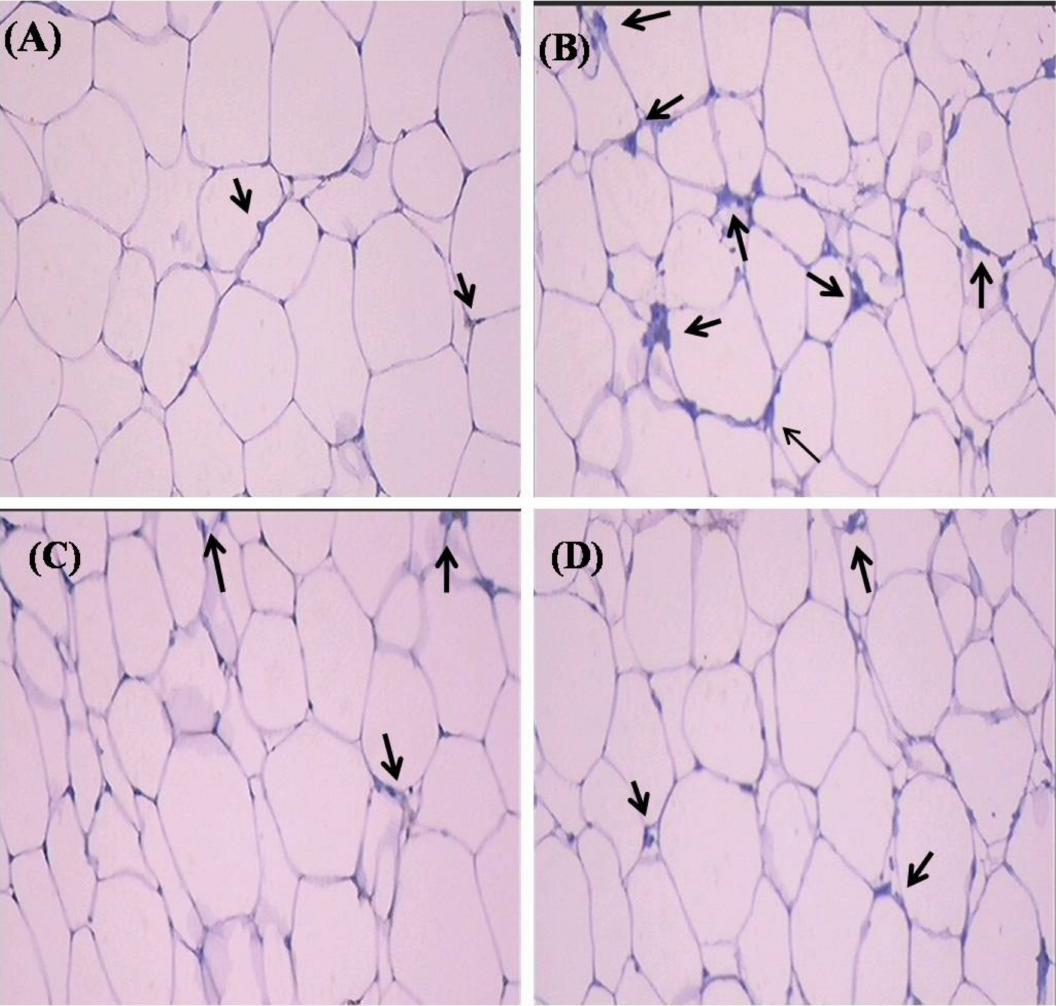
Figure 6. Effect of SIT on IL-6 protein expression in the adipose tissue of type-2 diabetic rats. The adipose tissue samples were dissected out from experimental rats and protein expression of IL-6 was measured by immunohistochemistry (IHC). The representative IHC photomicrographs (100 × magnification) of IL-6staining intensity (arrows) in the adipose tissue samples of experimental groups are shown in this figure. ( A ) Normal rats; ( B ) type-2 diabetic rats showed elevated expression of IL-6; ( C ) type-2 diabetic rat treated with β -sitosterol (20 mg/kg b.wt/day orally for 30 days) showed a considerable decline in the expression of IL-6 when compared with type-2 diabetic rats and ( D ) type-2 diabetic rats treated with metformin (50 mg/kg, b.wt/day orally for 30 days) showed a significant reduction in the IL-6 protein